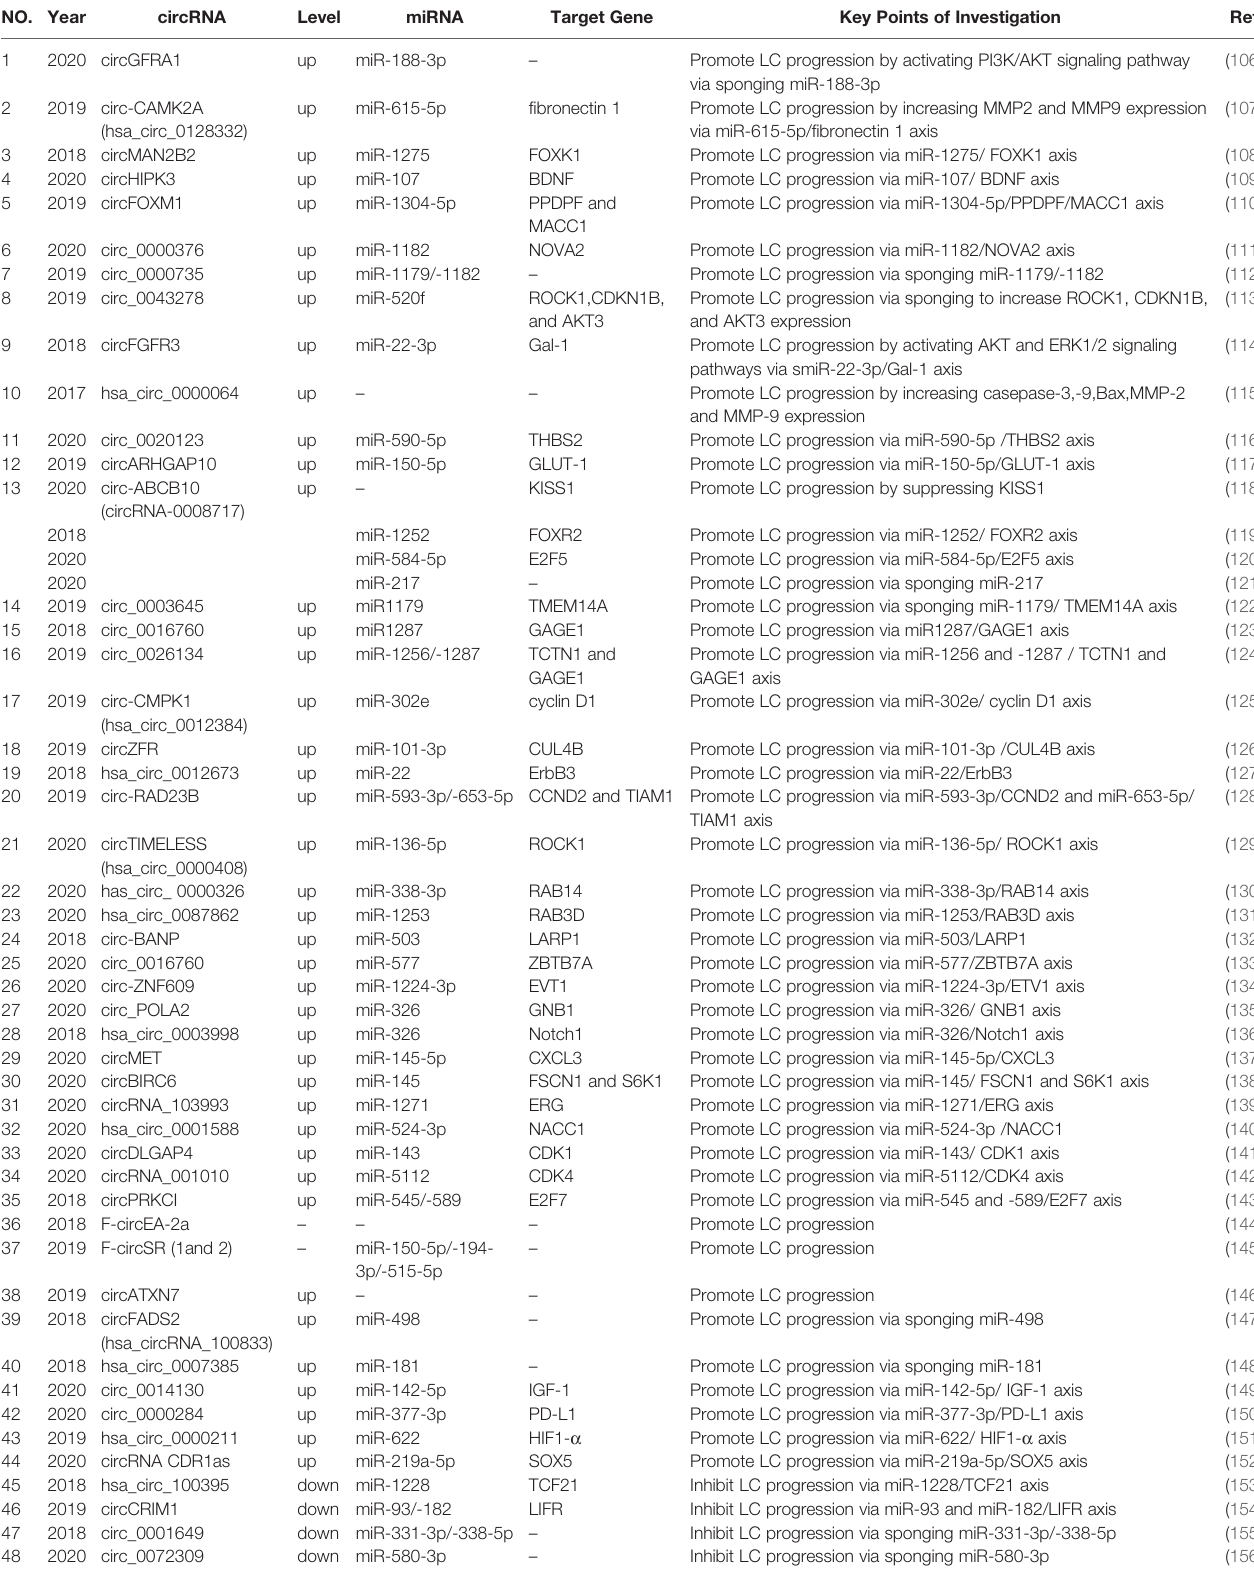
TABLE 2 | The circRNAs regulate lung cancer proliferation, migration and invasion via other